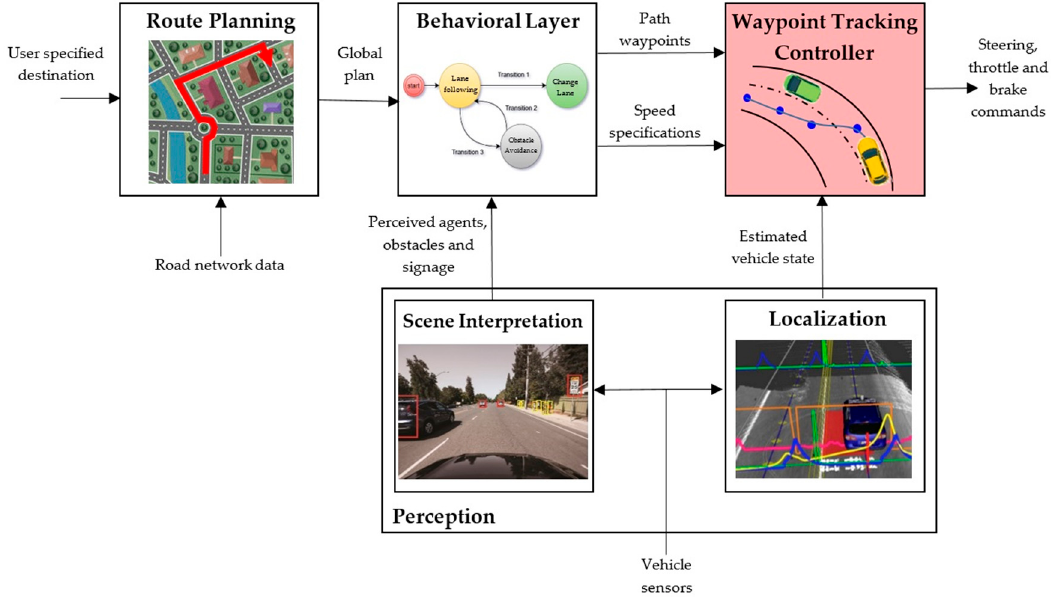
Figure 1. General navigation architecture of an autonomous vehicle. This work proposes a solution for the Waypoint Tracking Controller that receives as inputs a set of path waypoints and speed specifications along with the estimated vehicle state and generates as outputs the vehicle control signals.